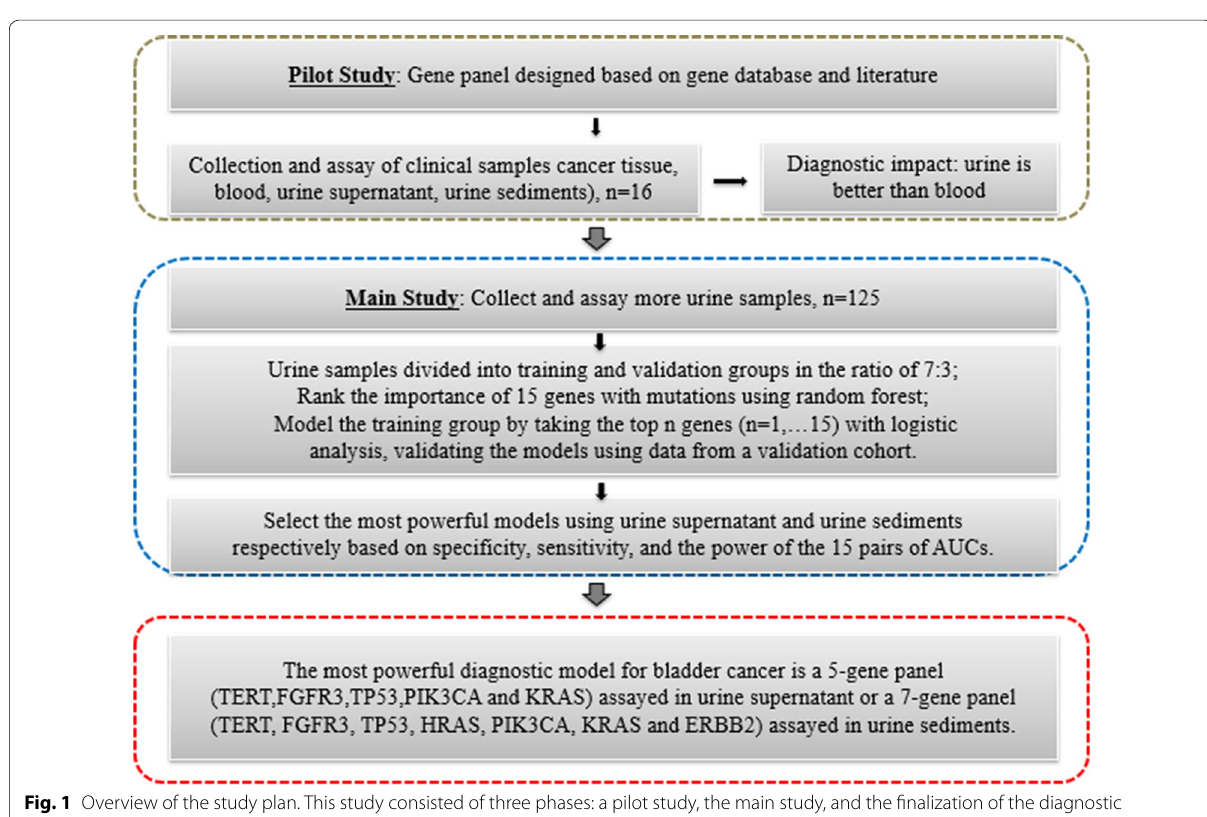
Fig. 1 Overview of the study plan. This study consisted of three phases: a pilot study, the main study, and the finalization of the diagnostic modeling, which are shown circumscribed in grey, blue, and red,